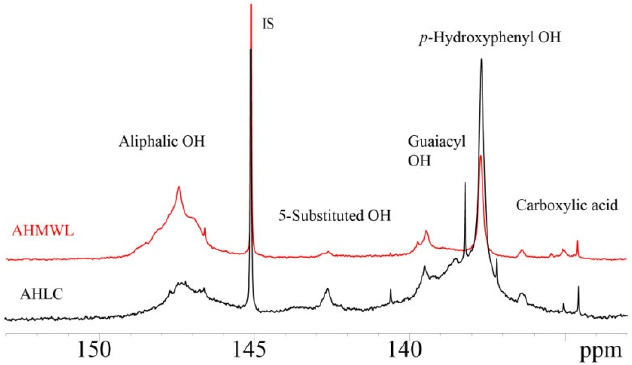
Figure 4. 31 P-NMR spectrum of AHMWL and AHLC. Table 6. Functional group contents of AHMWL and AHLC.